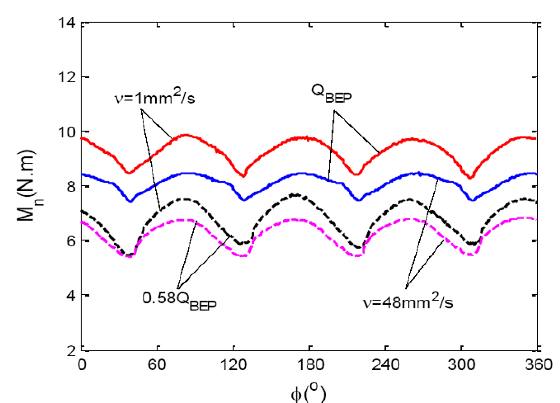
Figure 5. Torque on impeller in terms of its rotating angle at both best efficiency and part-loading points.